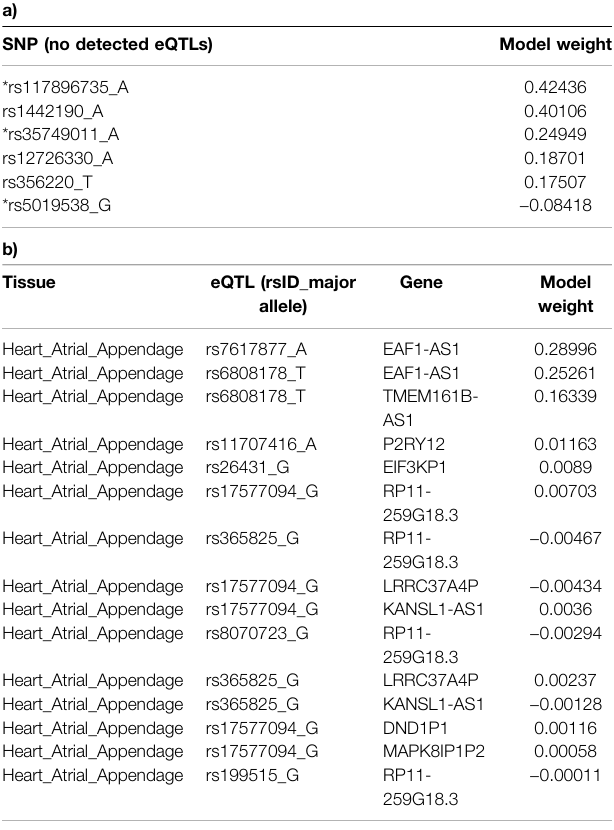
TABLE 1 | SNPs identi fi ed as being the main contributors to model-1. a) SNPs with no detected eQTL effects, and b) eQTL effects within the Heart Atrial Appendage. The model weight is the coef fi cient assigned to each variant or eQTL in the logistic regression predictor model-1. “ * ” indicates the non eQTL SNP is in the 90 SNPs of Nalls et